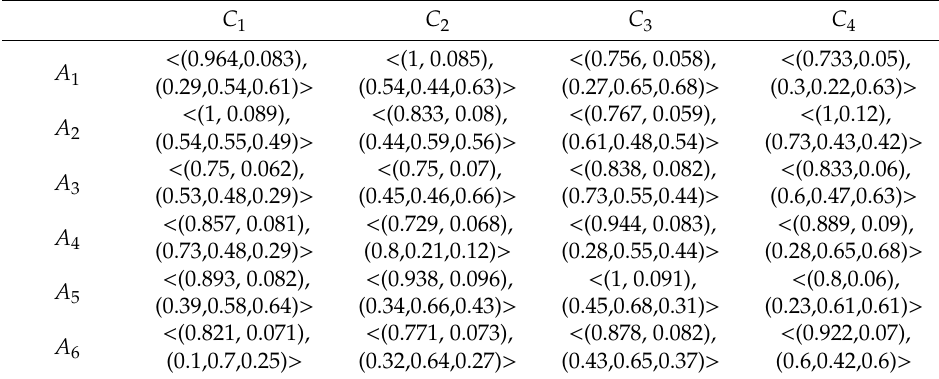
Table 2. Normalized decision information matrix.